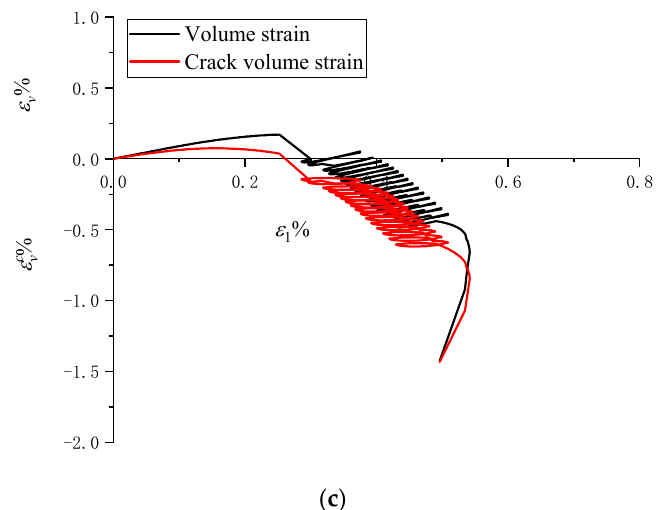
Figure 9. Volumetric strain of cracks under 60% of the UCS: ( a ) Gra60% − 1; ( b ) Gra60% − 2; ( c ) Gra60% − 3.